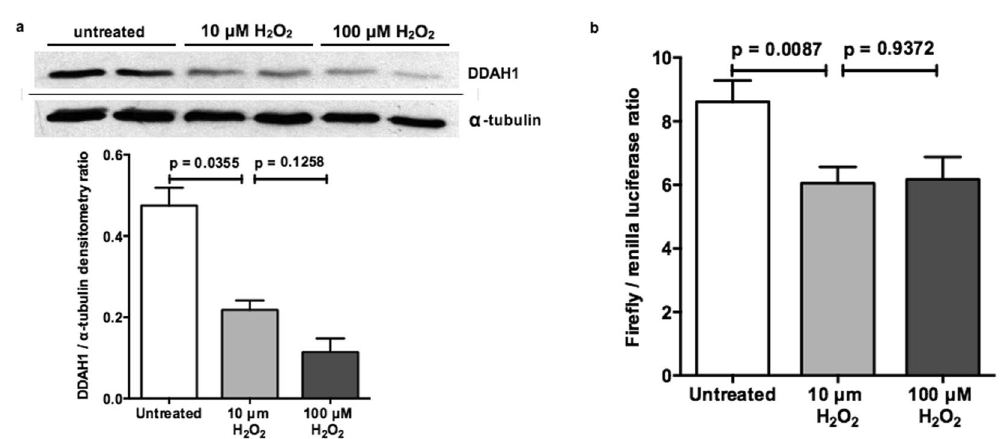
Figure 5. Oxidative stress reduces DDAH1 expression in hepatocytes by a post-transcriptional mechanism. ( a )Western blot analysis of HepG2 cells treated with 10 uM H2O2 show reduced DDAH1 protein expression compared to untreated cells. DDAH1 protein is further reduced in cells treated with 100 uM H2O2. Western blots were probed for DDAH1 and α -tubulin simultaneously. (Untreated n = 2; 10 uM n = 2; 100 uM n = 2). ( b ) HepG2 cells were transfected with a plasmid with the DDAH1 3 ′ UTR cloned downstream of the firefly luciferase coding sequence and luciferase activity (normalised to co-transfected Renilla luciferase activity) was measured. Cells treated with either 10 uM or 100 uM H2O2 showed reduced luciferase activity compared to untreated cells. (Untreated n = 6; 10 uM n = 6; 100 uM n =